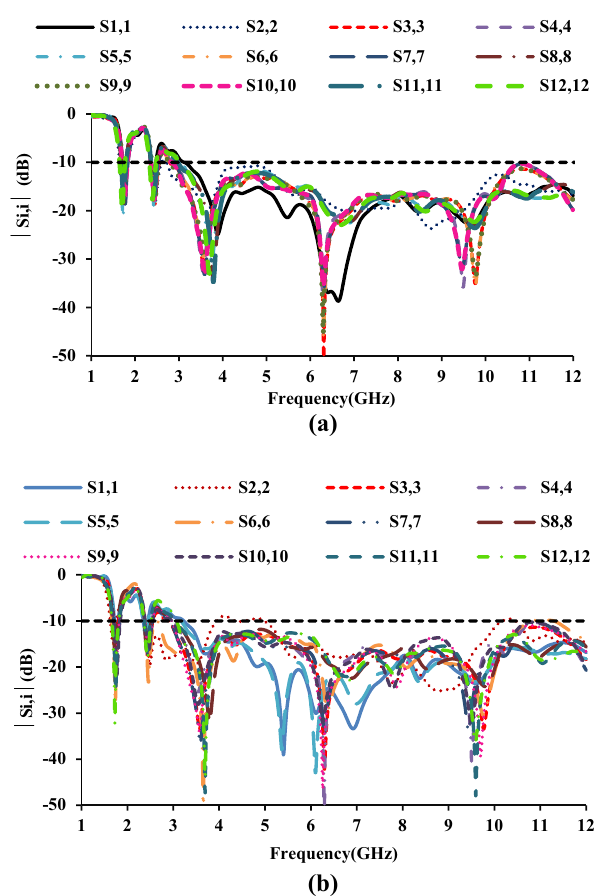
Figure 19. Effect of housing on the performance of the proposed antenna: ( a ) case-1 and ( b )